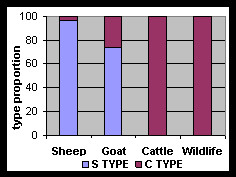
Strain type polarization in host species. Graphic representation showing the clear polarization of C and S strain types found in Spanish bovine, ovine, caprine and "wild" species.